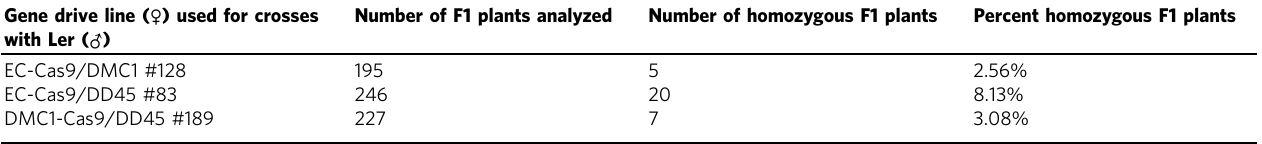
Table 2 The effects of promoters used for Cas9 expression on the ef fi ciencies of zygosity conversion. Gene drive line ( ♀ ) used for crosses with Ler ( ♂